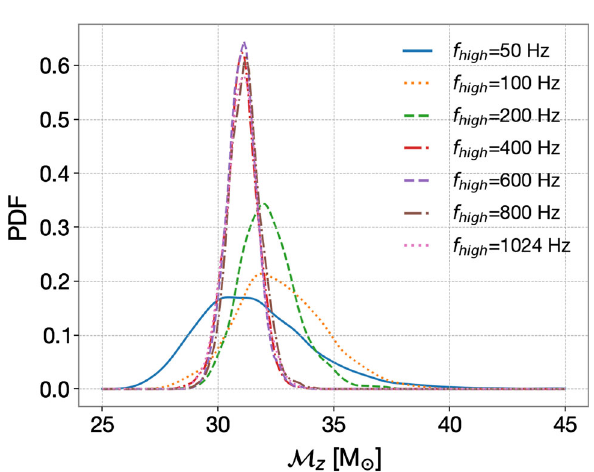
Table 1 The constraints on dipole radiation of five selected binary BH events, 90% confidence intervals are shown